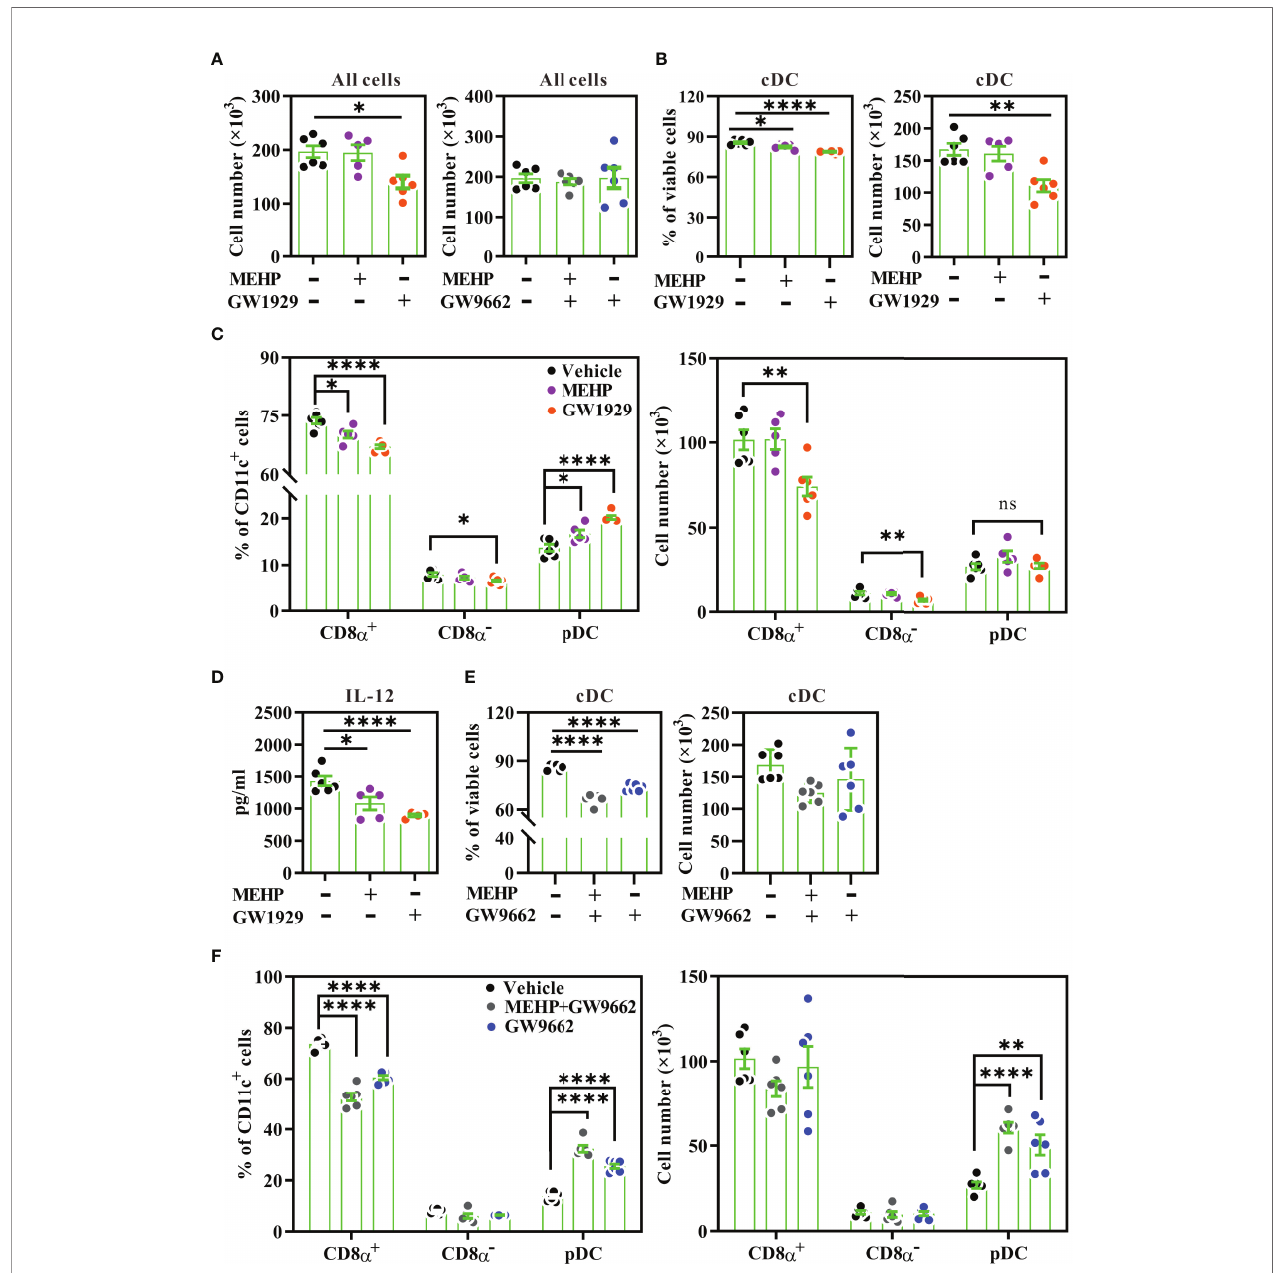
FIGURE 5 | DC subset analysis in Flt3L-induced bone-marrow culture. Bone marrow cells from BALB/c mice were treated with various concentrations of MEHP (20 m M), GW1929 (4 m M), and/or GW9662 (4 m M) for 7 d, in the presence of rmFlt3L. Day-8 FL-DCs were harvested for subset analysis using multi-parametric fl ow cytometry. The gating strategy is shown in Supplementary Figure 3 . (A) Total cell numbers of day-8 FL-DCs treated with MEHP, GW1929, and/or GW9662. (B) The percentages and cell numbers of cDCs gated from viable FL-DCs treated with MEHP or GW1929. (C) The percentages and cell numbers of CD8 a + DCs, CD8 a - DCs, and pDCs gated from CD11c + cells treated with MEHP or GW1929. (D) IL-12 levels of treated FL-DCs after stimulation with CpG1826 for 24 h. (E) The percentages and cell numbers of cDCs gated from viable FL-DCs treated with MEHP and/or GW9662. (F) The percentages and cell numbers of CD8 a + DCs, CD8 a - DCs, and pDCs gated from CD11c + cells treated with MEHP and/or GW9662. n=5 or 6 for each treatment. Results are represented as mean ± SEM. *P < 0.05, **P < 0.01, and ****P < 0.0001, as assessed using one-way ANOVA followed by Dunnett ’ s multiple comparison test. ns, non-signi fi